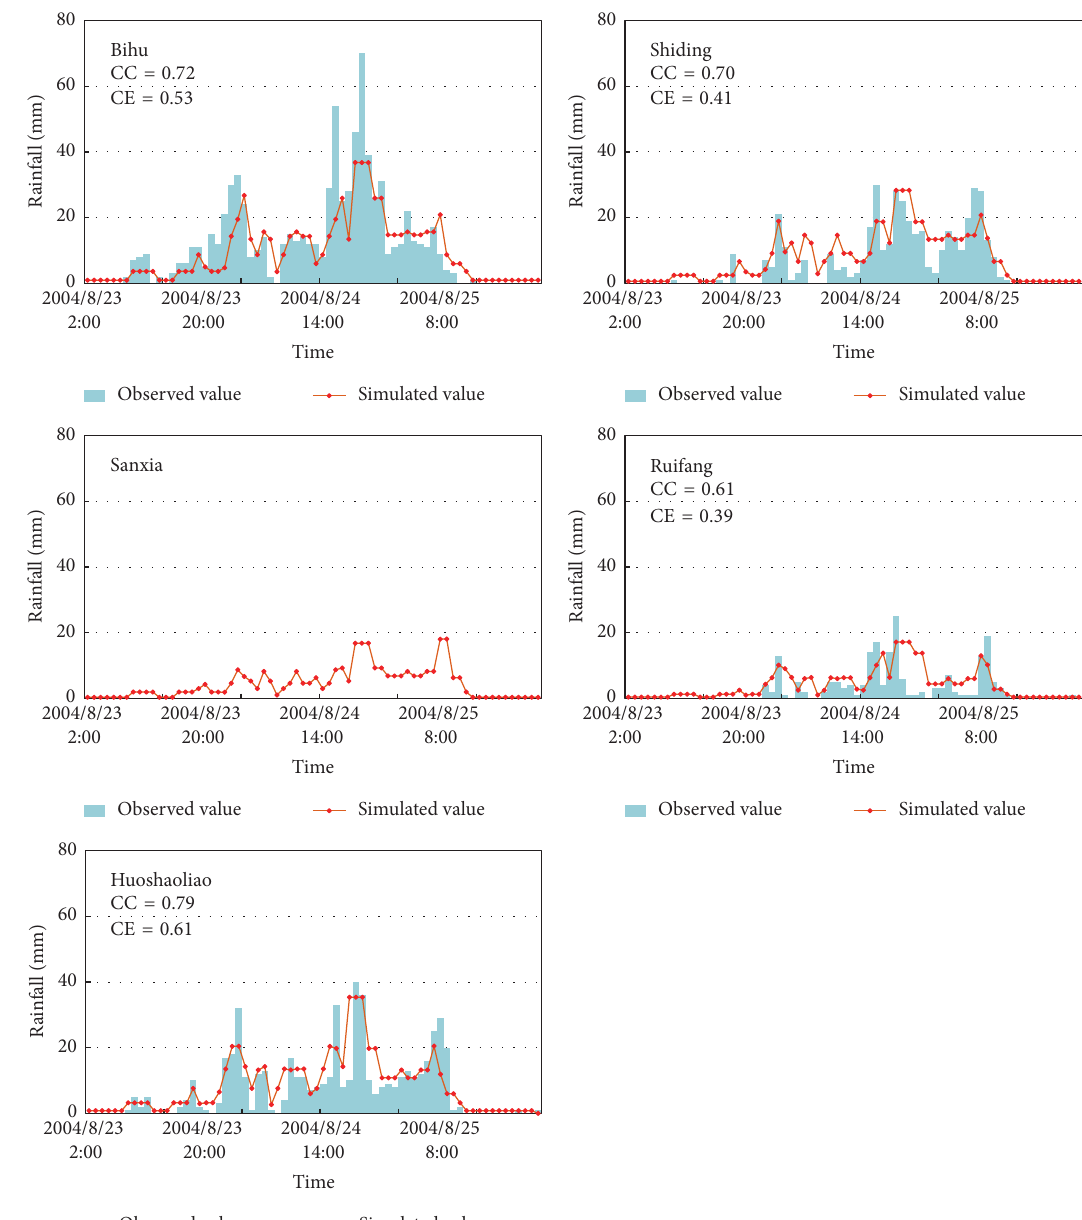
Figure 6: Results of hourly rainfall forecast during Typhoon Aere (2004) (data at Sanxia gage was missing).